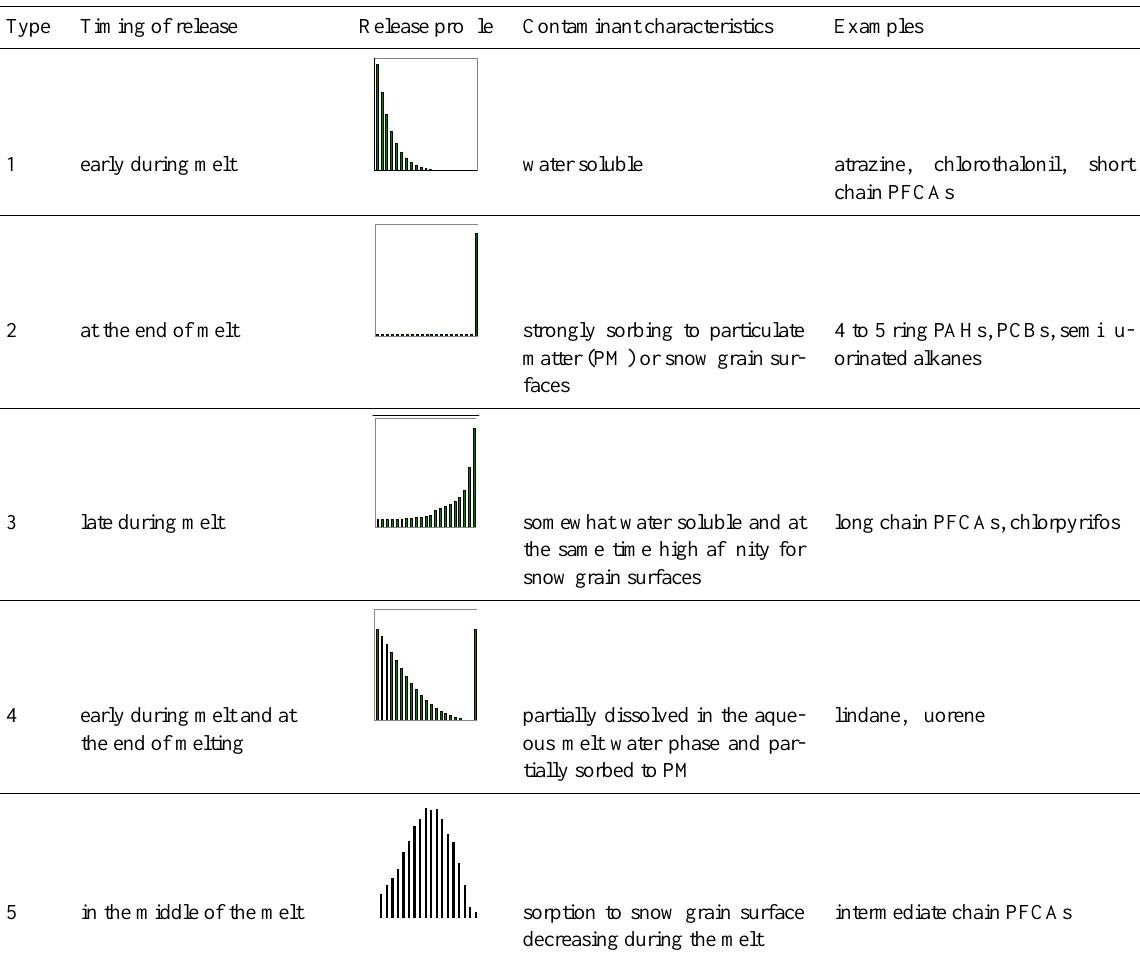
Table 2. Types of snowpack elution behavior observed in the laboratory. Release profiles based on 2289 experimental data; example contaminants that follow these elution profiles are also listed.